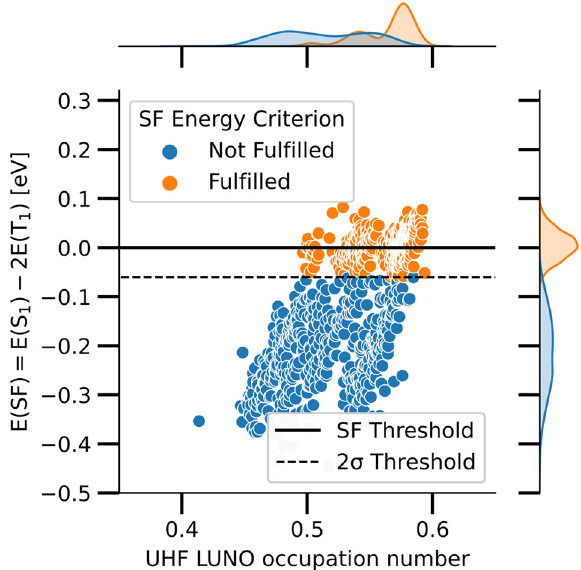
Fig. 7 Correlation diagram between the singlet fi ssion energy criterion E (SF) and the biradical value y 0 . Note that 48.3% of the 921 molecules ful fi l SF conditions when values of up to E (SF) = − 0.06 eV are allowed (see dashed line), which represents two times the standard deviation of the energy prediction models that the classi fi er learned from.